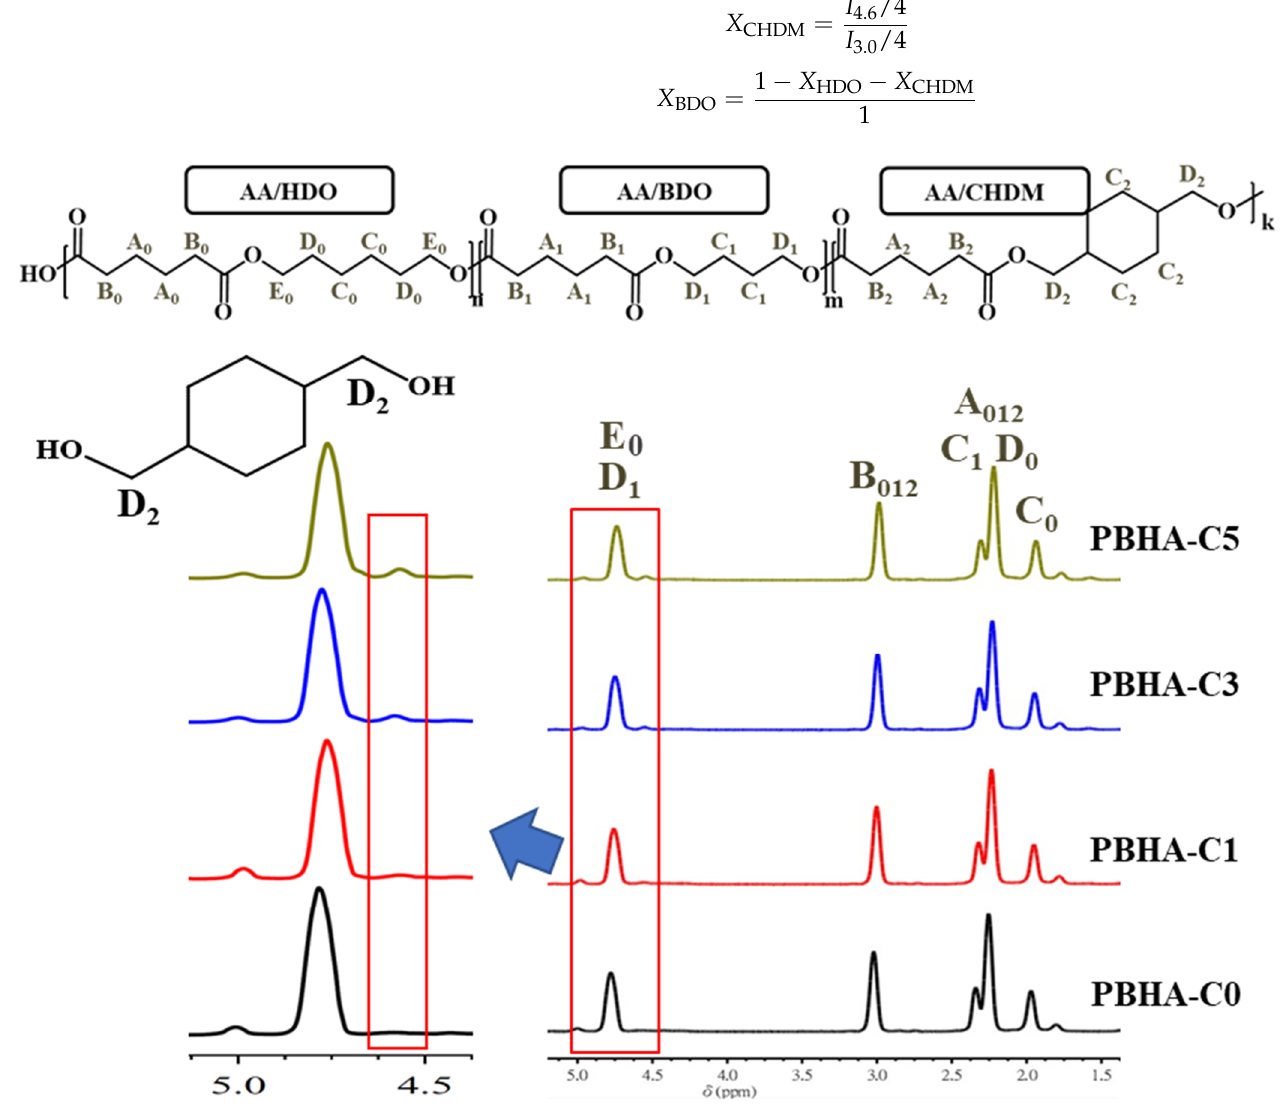
Figure 1. 1 H-NMR spectrum of PBHA-Cn copolymers.